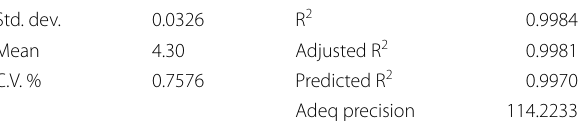
Table 4 Key results from ANOVA (Compressive) Std. dev.